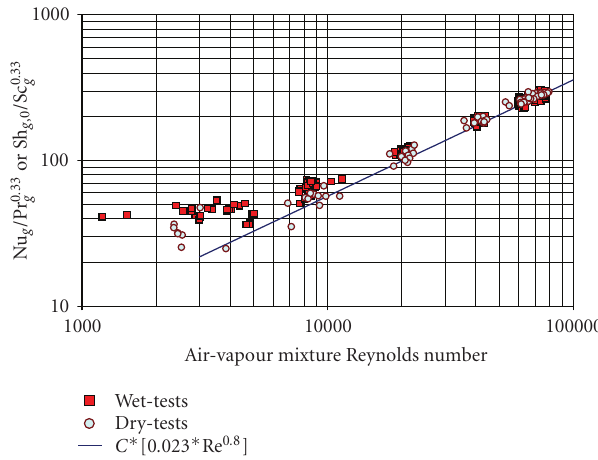
Figure 5: Comparison of dry and wet test data in the experimental test series at 50 ◦ C and 60 ◦ C of plate temperature in the EFFE experiments